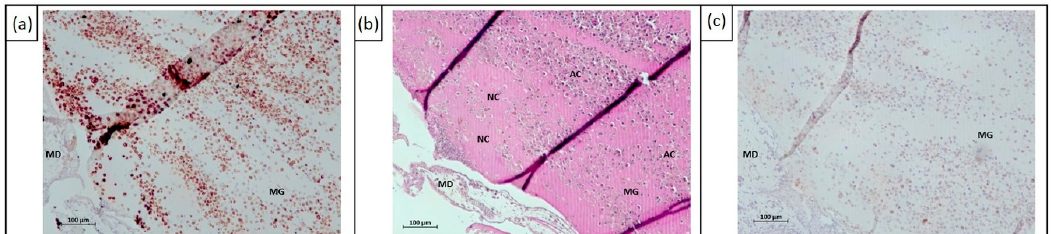
Figure 5. IHC stains of UM cells in the CAM at E16 following intraarterial electrochemotherapy using 2.5 µg/mL bleomycin and eight pulses of 750V/cm pulse strength. ( a ) Human UM cells 92.1 were immunohistochemically stained with antihuman melanosome marker; ( b ) the viability of cells has been controlled using PAS staining and detection of necrotic cells by hematoxylin-negative nucleus; apoptotic cells are characterized by chromatin condenses and apoptotic bodies; ( c ) Ki67 staining of CAM, including 92.1 cells, was negative. Abbreviation: AC = apoptotic cells, MD = chorionic mesoderm, MG = Matrigel graft, NC = necrotic cells. Scale bars = 100 µm. The intratumoral ECT led to large intratumoral areas of necrosis in the center of the Matrigel grafts (Figure 6). In the embryonic mesoderm, the cell death of infiltrating UM cells was observed. In peripheral regions of the Matrigel grafts, tumor cells were Ki67+ and showed almost no cytotoxic effects. Both 2.5 µg/mL and 1.0 µg/mL bleomycin caused cytotoxic effects.